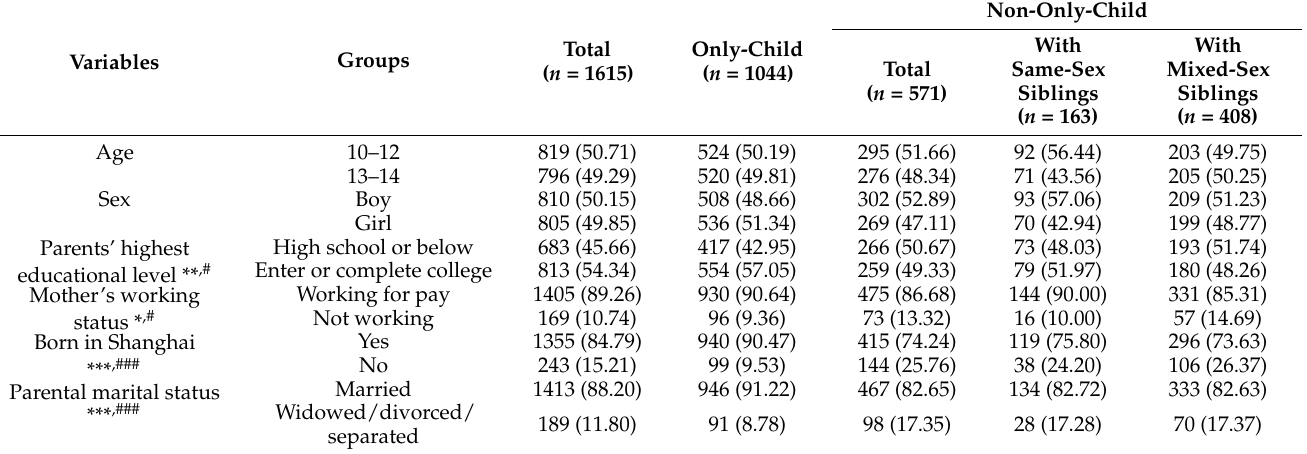
Table 2. Distribution of demographic characteristics among only-child and non-only-child early adolescents ( n